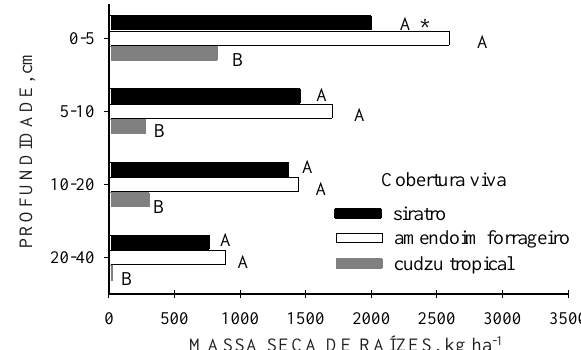
Figura 1. Distribuição de matéria seca de raízes